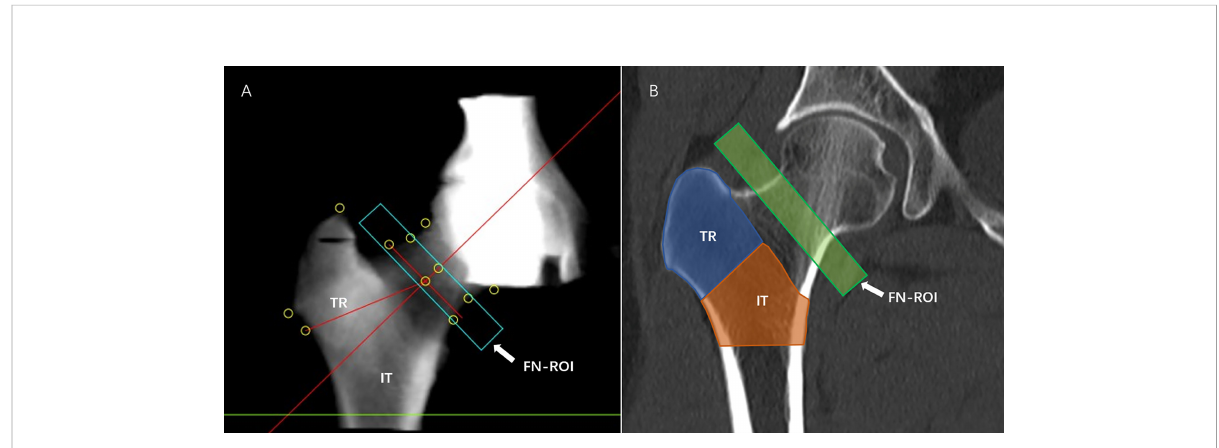
FIGURE 3 aBMD measurement. QCTPro CTXA was used to analyze the aBMD of the proximal femur, including the FN, TR, and IT (A, B) .